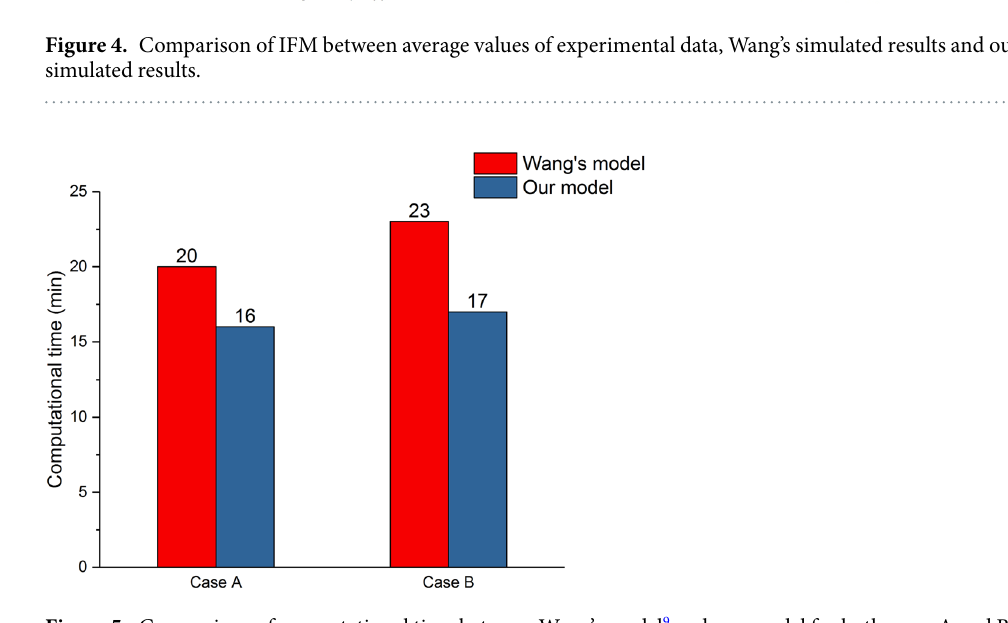
Figure 5. Comparison of computational time between Wang’s model 9 and our model for both cases A and B.